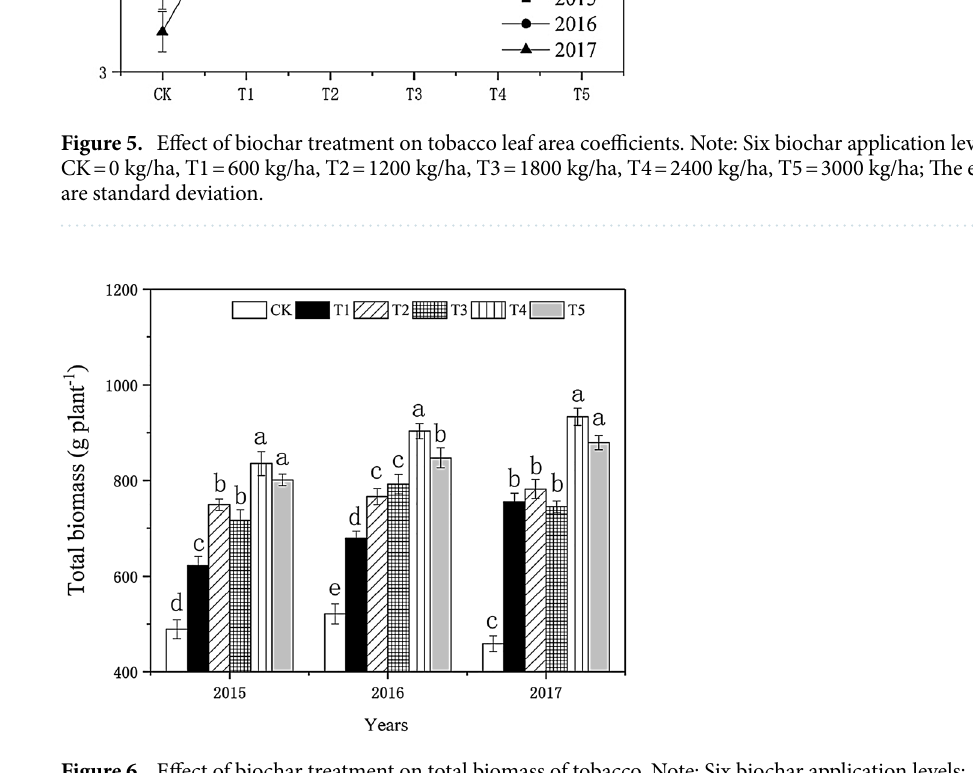
Figure 6. Effect of biochar treatment on total biomass of tobacco. Note: Six biochar application levels: CK = 0 kg/ha, T1 = 600 kg/ha, T2 = 1200 kg/ha, T3 = 1800 kg/ha, T4 = 2400 kg/ha, T5 = 3000 kg/ha; The error bars are standard deviation; different letters on the error lines indicate significant differences between the different treatments (α =